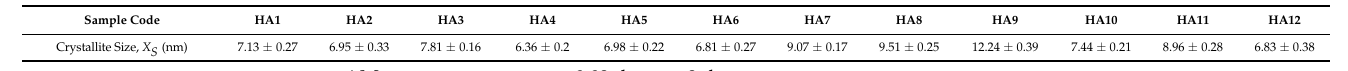
Table 2. Crystallite size calculated from the XRD patterns